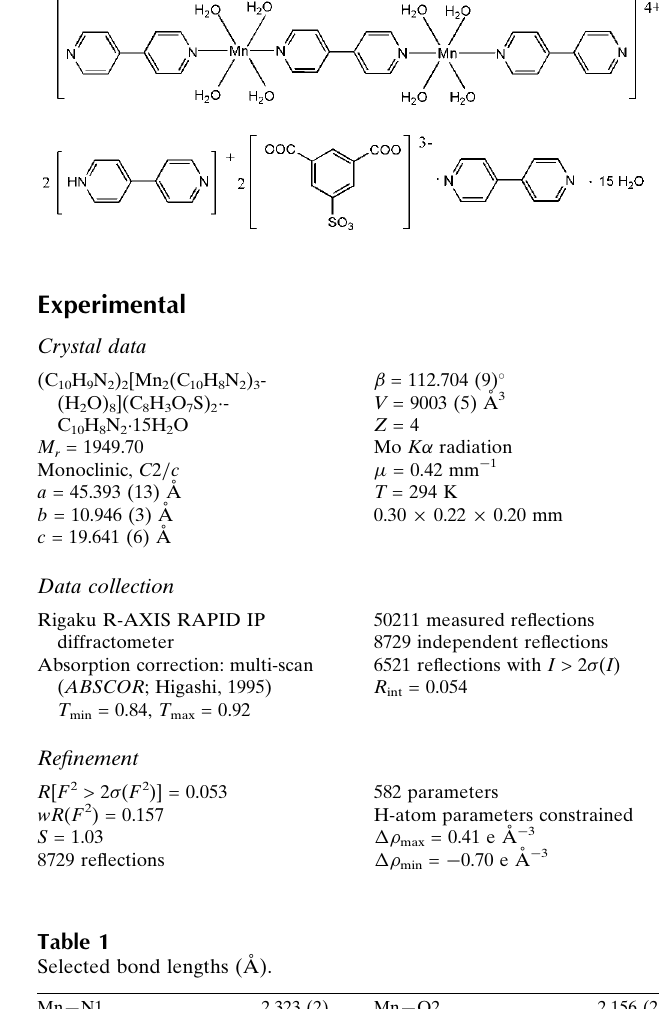
Selected bond lengths (A˚ ).